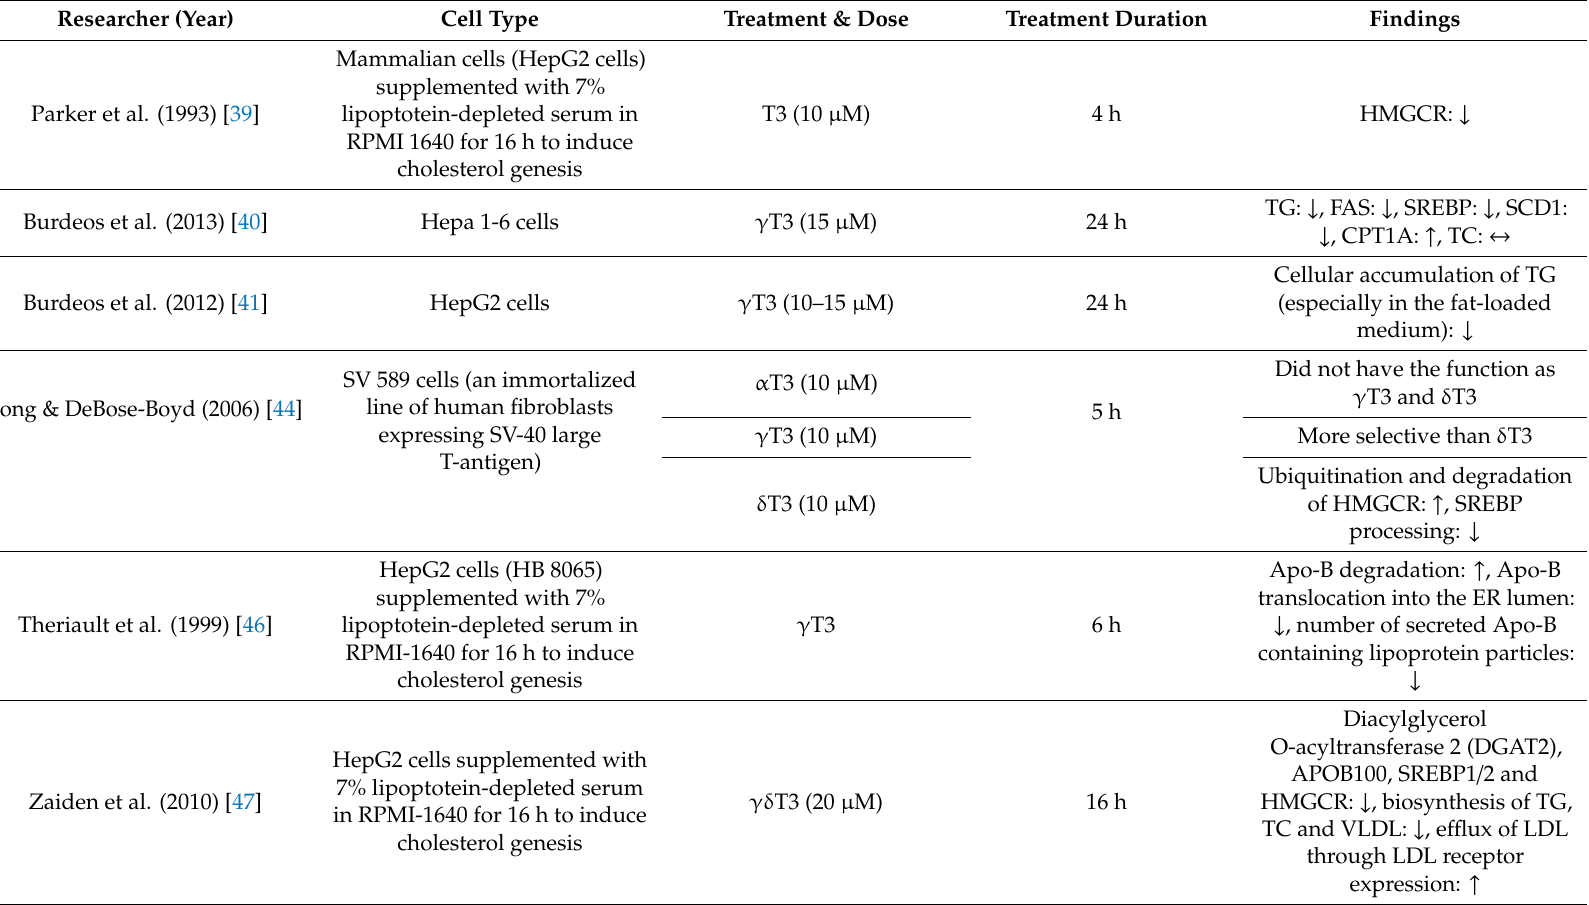
Table 1. E ff ects of T3 on lipid metabolism in